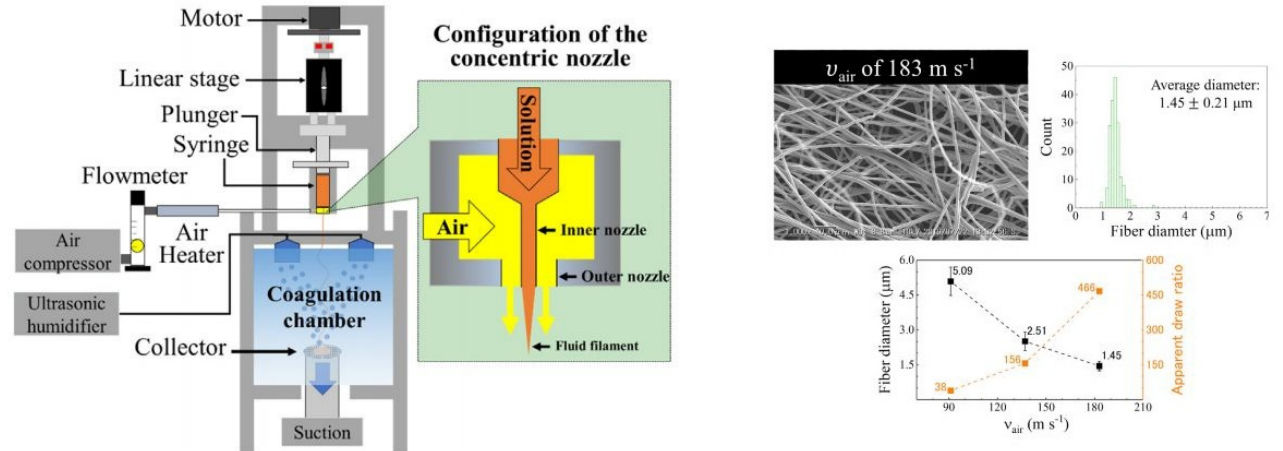
Figure 8. Schematic representation of wet solution blow spinning apparatus of cellulose fibers with mist coagulation chamber (left) and dependency of fiber diameter on air velocity during solution blow spinning (reprinted from the European Polymer Journal , 2020 , 125 , 109513, Zhang, J.; Kitayama, H.; Gotoh, Y. High strength ultrafine cellulose fibers generated by solution blow spinning, with permission from